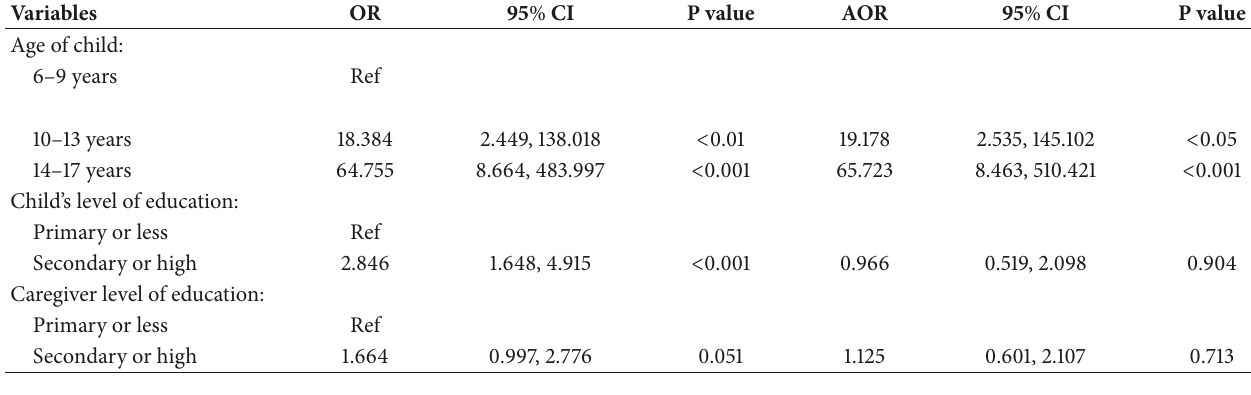
Table 3: Crude and adjusted odds ratio for factors associated with HIV status disclosure, among children between 6 and 17 years on ART therapy, in Southern Highlands Zone, Tanzania (N=309).